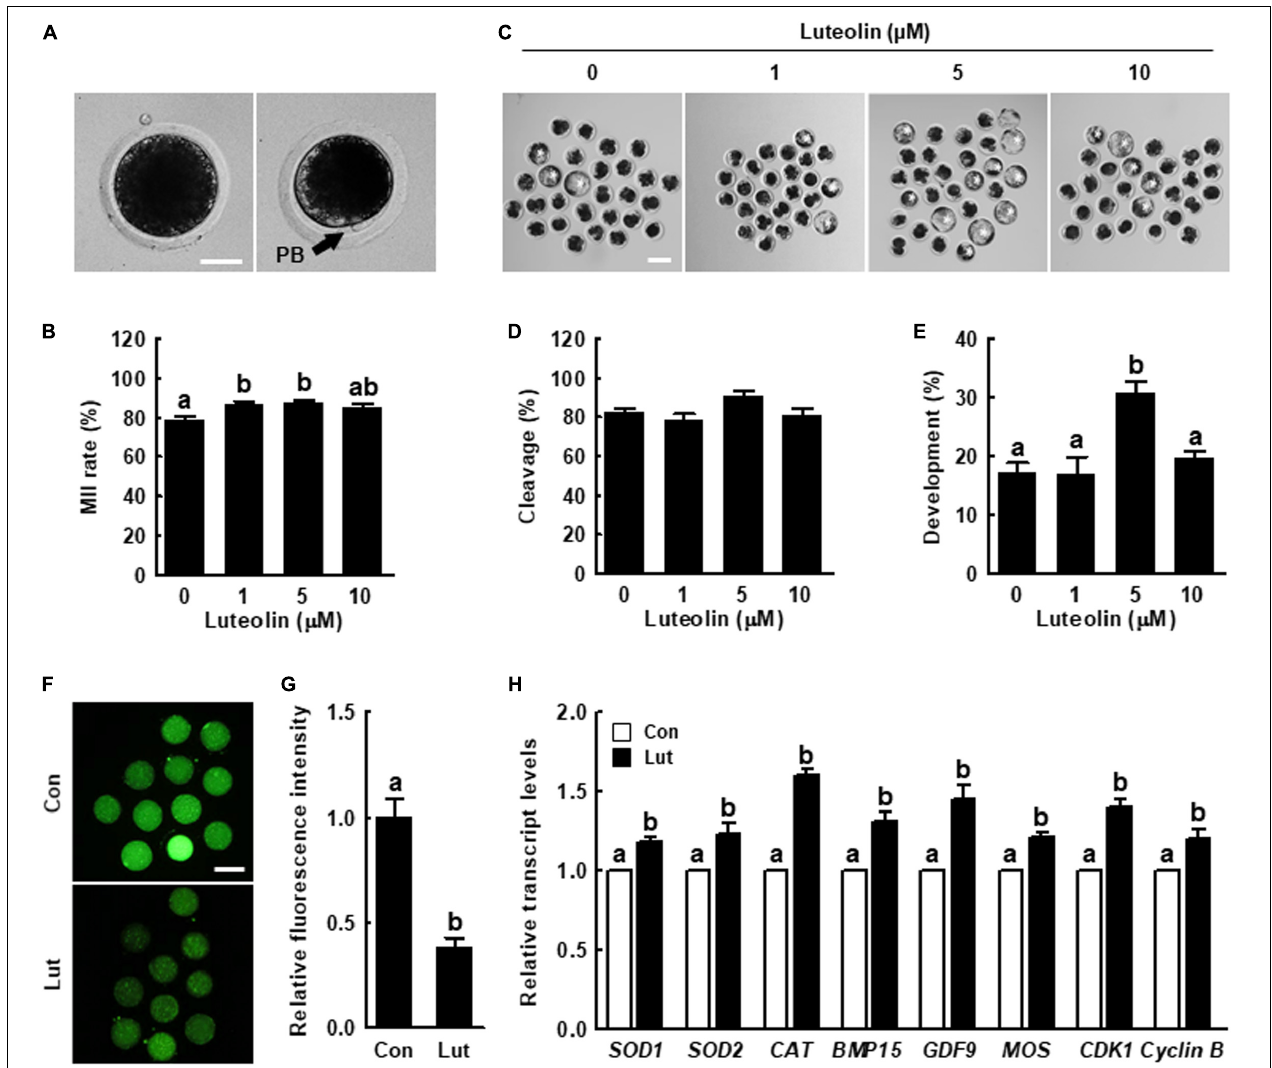
FIGURE 1 | Effects of luteolin (Lut) on meiotic maturation and subsequent embryonic development in porcine embryos after parthenogenetic activation. (A) Representative images of porcine oocytes with or without polar bodies. Scale bar = 50 µ m. (B) Percentages of metaphase II (MII) oocytes after in vitro maturation (IVM) in the indicated groups (0 µ M, n = 182; 1 µ M, n = 180; 5 µ M, n = 178; 10 µ M, n = 182). (C) Representative images of blastocyst formation in the indicated groups. Scale bar = 100 µ m. Rates of (D) cleavage and (E) blastocyst formation in the indicated groups (0 µ M, n = 103; 1 µ M, n = 103; 5 µ M, n = 111; 10 µ M, n = 106). (F) Representative fluorescent images and (G) relative intensity levels of reactive oxygen species (ROS) in the indicated groups (control [Con], n = 28; Lut, n = 28). Scale bar = 100 µ m. (H) Relative expression of oxidative stress- and oocyte competence-related genes in the indicated groups. The data are from at least three independent experiments, and the different superscript letters represent the significant difference ( p <